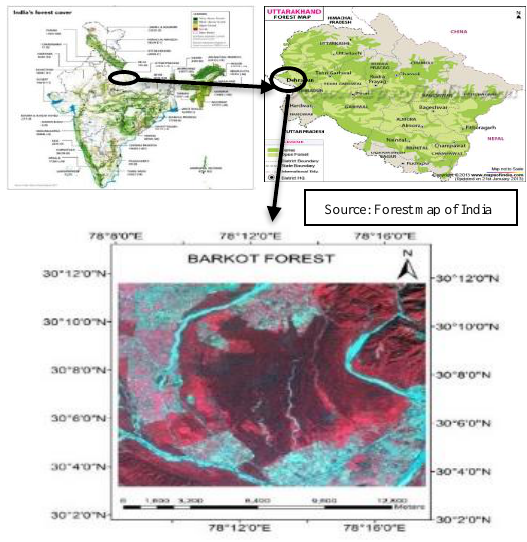
Figure 5: Study Area of Barkot Forest Dehradun, India